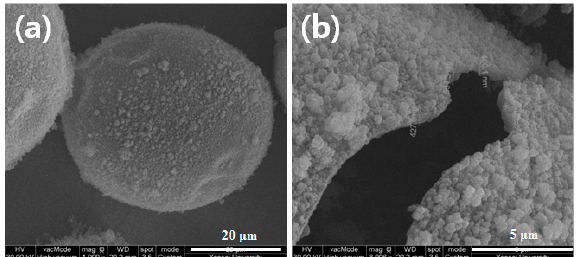
Figure 9. FE-SEM images of ( a ) n -hexadecane-loaded microcapsules prepared by oil-in-water Pickering emulsion templating and ( b ) the microcapsule shell wall.